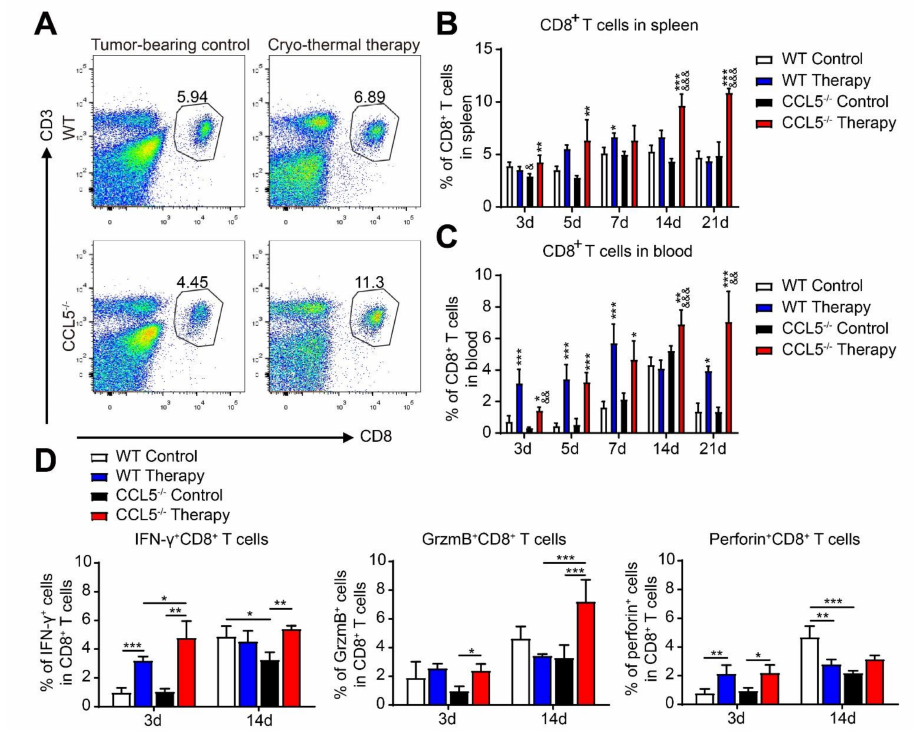
Figure 6. CCL5 deficiency promoted the cryo–thermal therapy-induced cytotoxic CD8 + T cells after treatment. ( A ) Gating strategy for the determination of CD3 + CD8 + T cells in the spleen and blood. Analysis of the CD8 + T cell proportions in the spleen ( B ) and peripheral blood ( C ) after treatment. ( D ) The expression levels of the cytotoxic cytokines of CD8 + T cells on days 3 and 14 after treatment were detected with FACS. n = 4 per group; mean ± SD. The data of FACS were analyzed with FlowJo 7. * p < 0.05; ** p < 0.01; *** p < 0.001, compared to WT tumor-bearing control or CCL5 − / − tumor-bearing control. & p < 0.05; && p < 0.01; &&& p < 0.001, compared to WT